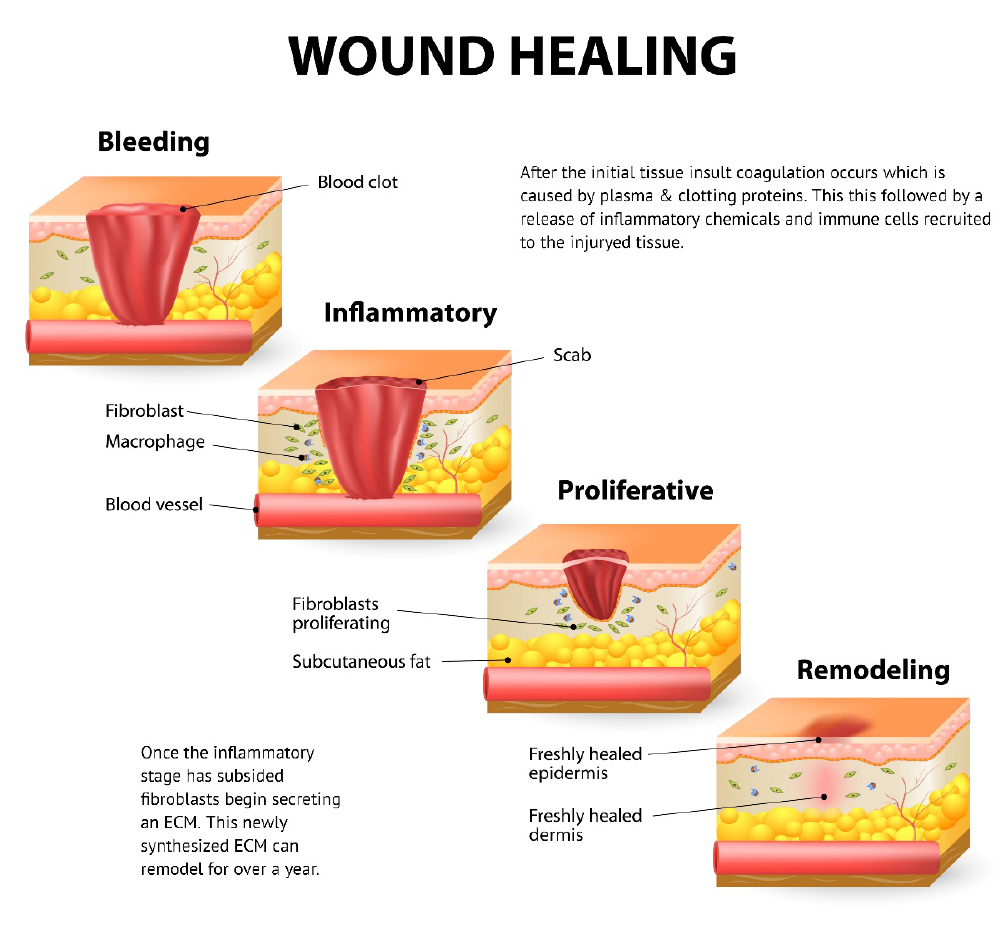
Figure 3. Phases of the wound healing response including hemostasis (coagulation), inflammation, proliferation, and tissue remodeling (Designua/Shutterstock.com).